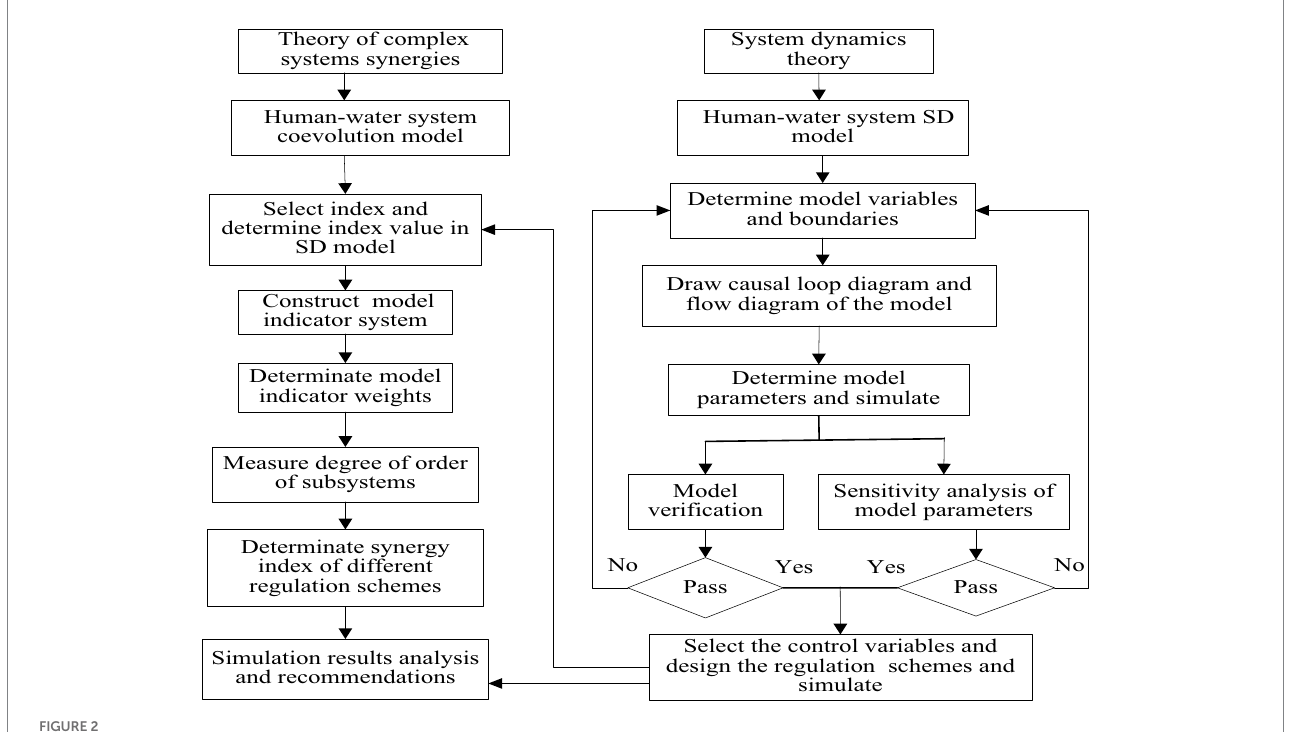
FIGURE 2 A flowchart illustrating the methodology of this